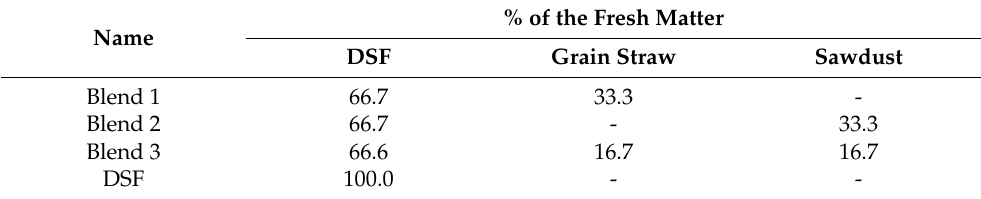
Table 1. Composition of blends used for the production of solid